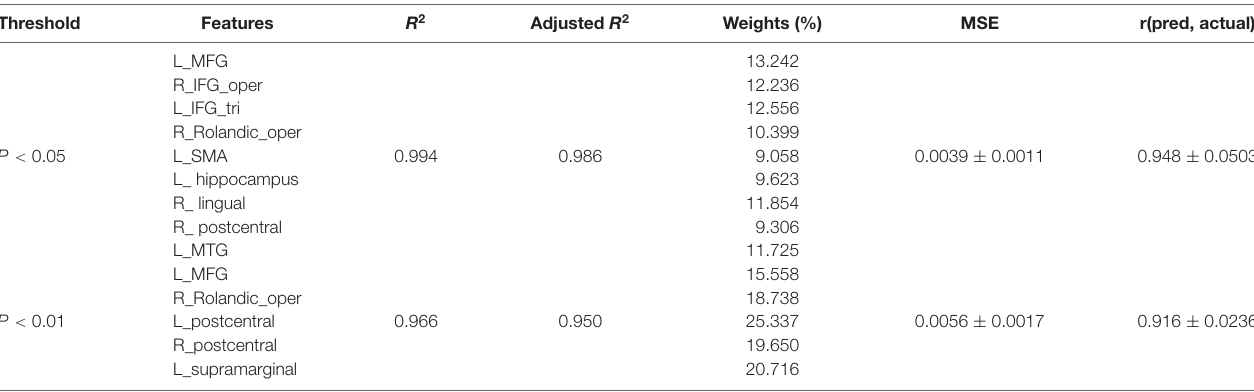
TABLE 1 | Prediction performance using linear regression